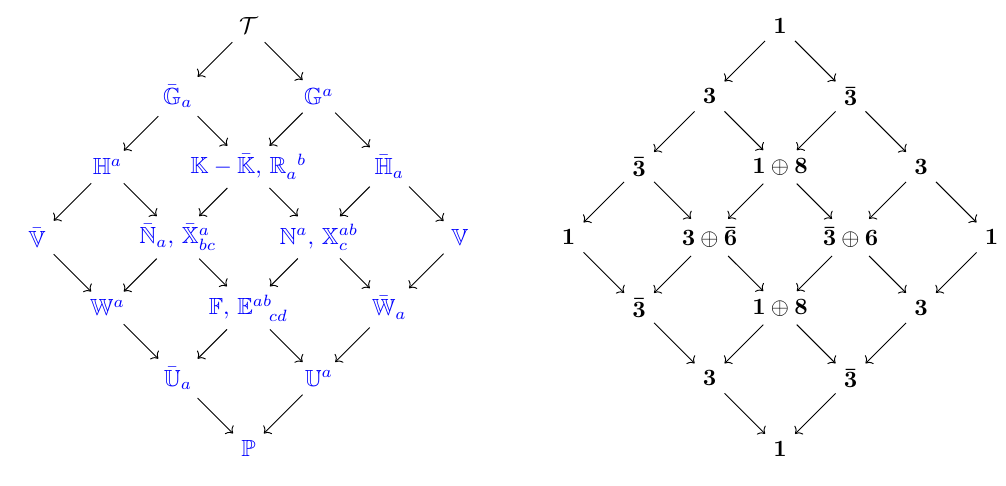
Figure 1. Diamonds corresponding to the T supermultiplet. Arrows pointing towards the left (right) mean the application of one ¯ Q a ( Q a ). The left diagram shows how the various components have been named in the main text. The right diagram provides their decomposition in terms of SU(3) irreducible